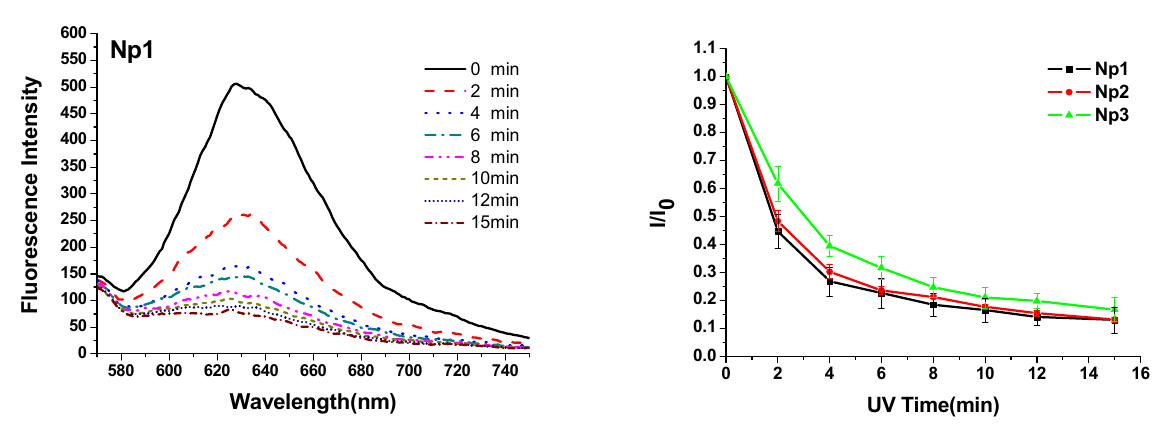
Figure 4. ( a ) Fluorescence spectra of Nile red-loaded Np1 solution upon light irradiation (365 nm, 11 mW/cm 2 ) with excitation wavelength at 550 nm; ( b ) Plots of normalized fluorescence intensity of Nile red at 630 nm vs . irradiation time for aqueous solutions of Np1 – 3